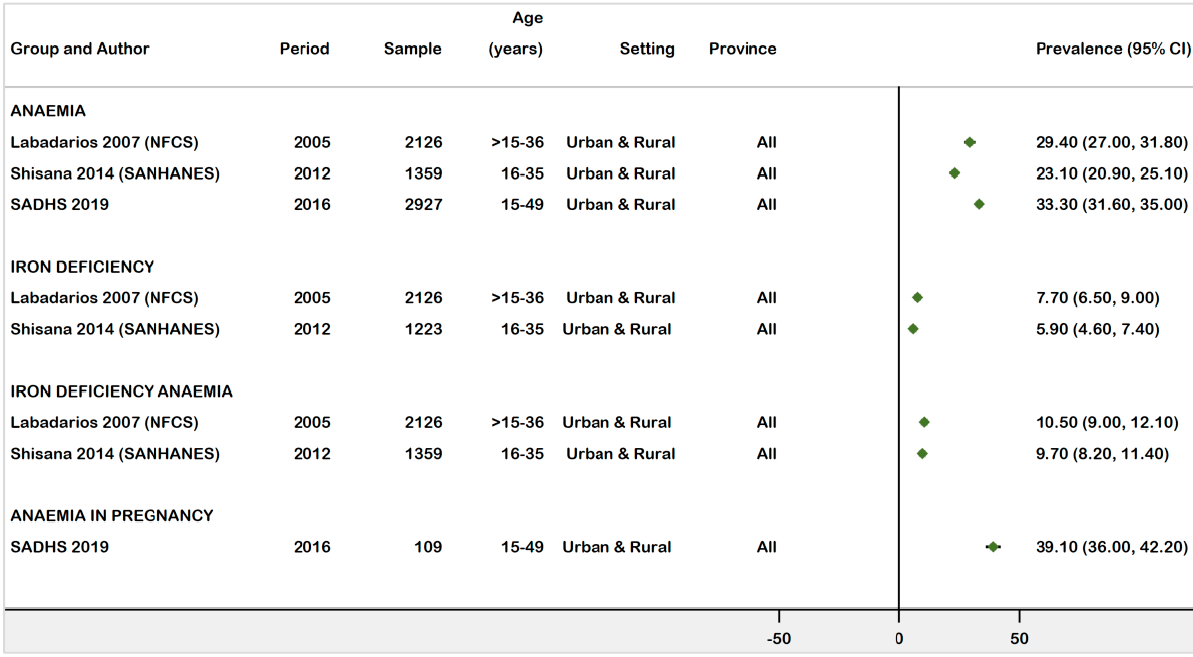
Figure 3. Forest plot of national prevalence of anaemia, ID, and IDA in WRA in South Africa (15–49 years), 1997–2021.